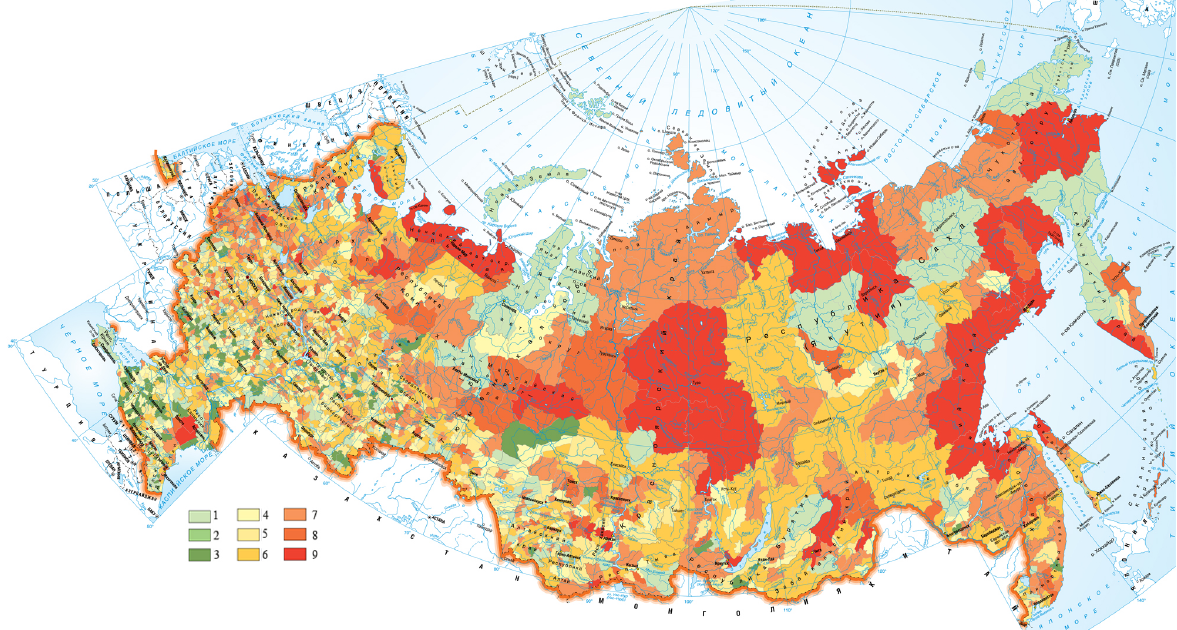
Figure 13. Frequency of natural and technological emergencies according to statistical analysis of EMERCOM DB on event information about emergency consequences for the period 1992–2008: number of events per year: 1 – fewer than 1; 2 – 1 up to 10; 3 – 10 up to 50; 4 – 50 up to 100; 5 – 100 up to 150; 6 – 150 up to 300; 7 – 300 up to 600; 8 – 600 up to 1000; 9 – more than 1000; map based on layers from the